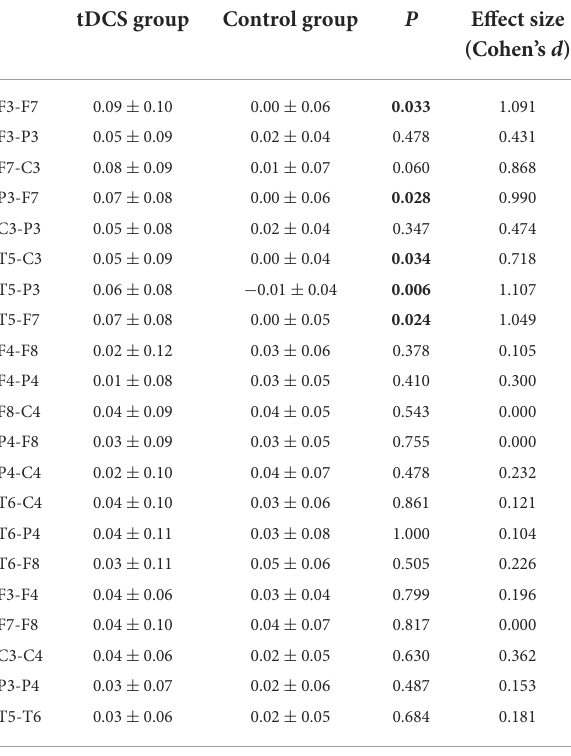
TABLE 6 The comparison of changes in the difference value of the cross-approximate entropy (C-ApEn) between two groups. tDCS group Control group P Effect size (Cohen’s d